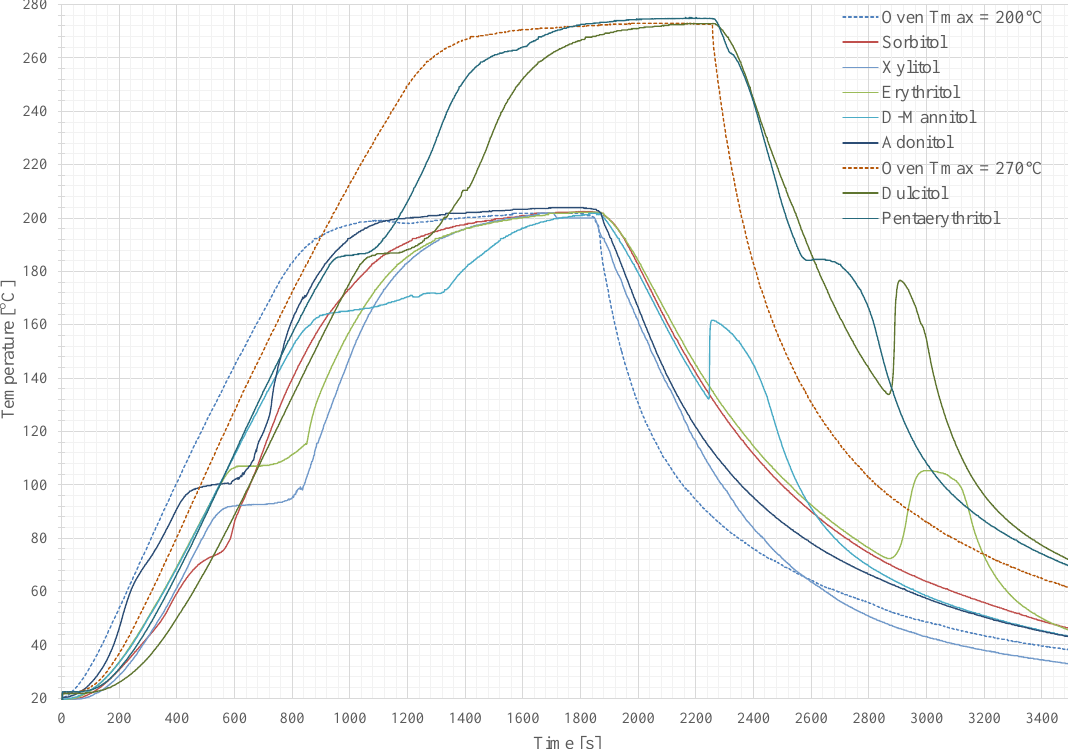
Figure 5. Temperature curves over time of the screened sugar alcohols with heat up and cool down phase. Each plateau in the heating part describes the melting process, where the temperature stays constant. The second plateau is reported as the material reached the ambient oven temperature. In the cooling state, the additional heating is caused by the recrystallisation of the PCM where the stored heat is